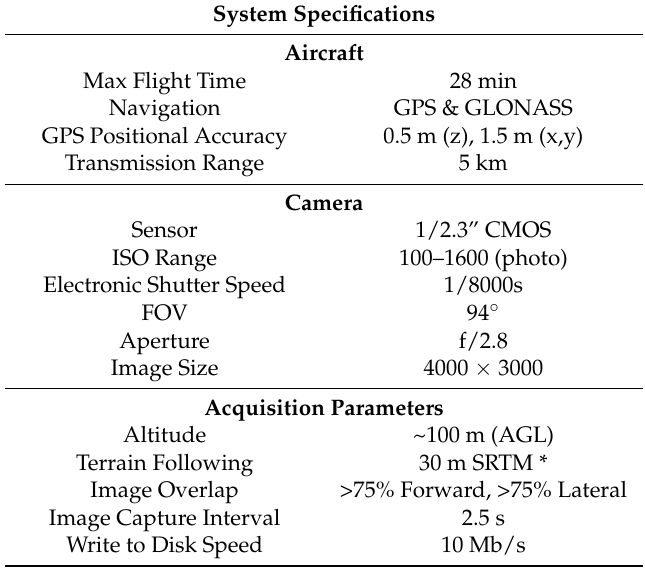
Table 2. UAS specifications of the DJI Phantom 4 and parameters used for image acquisition.